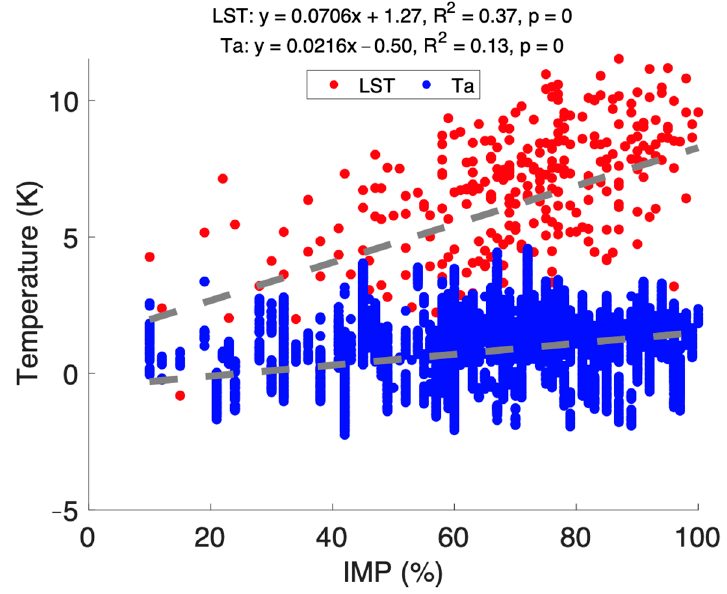
Figure 18. Dependence of air temperature (Ta) and LST on impervious surface fraction (IMP) for 12 August 2019.